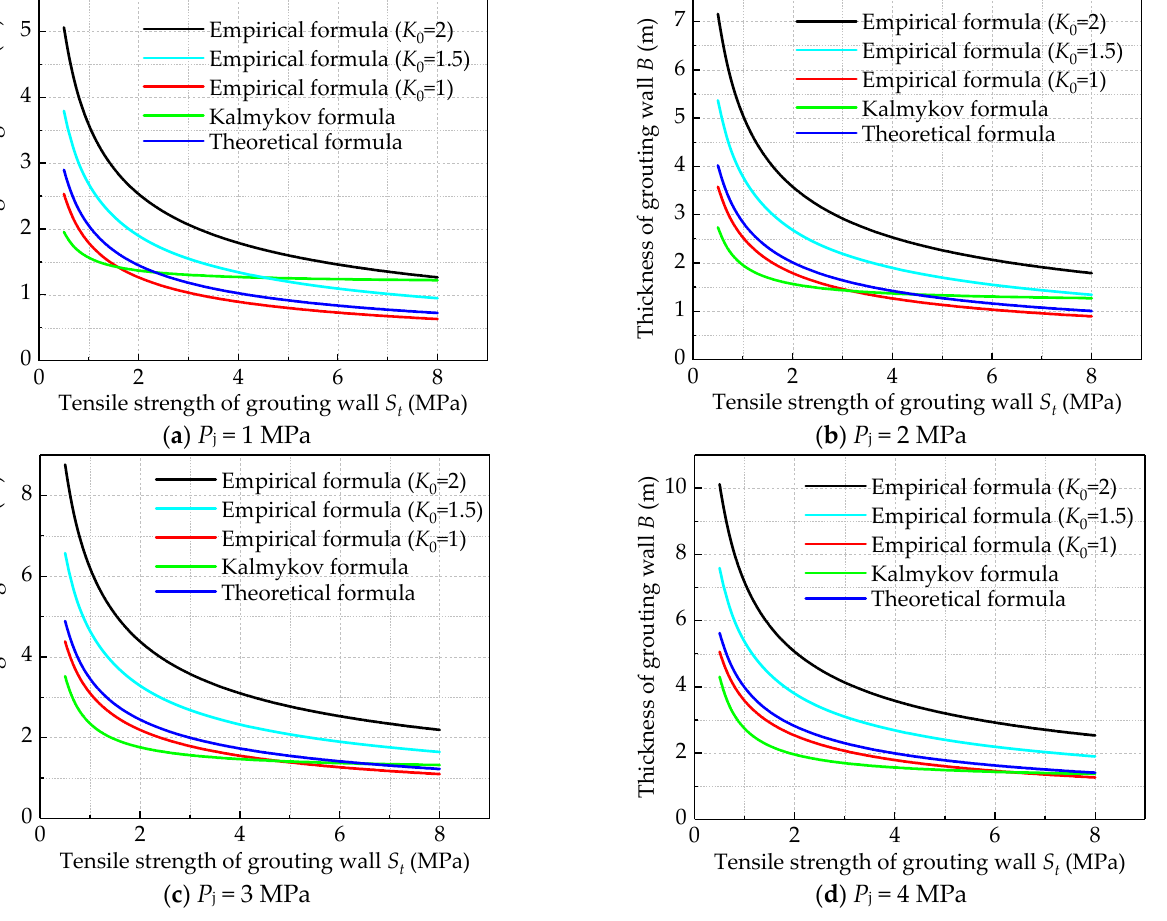
Figure 7. Relation between the thickness of concrete retaining wall and tensile strength.